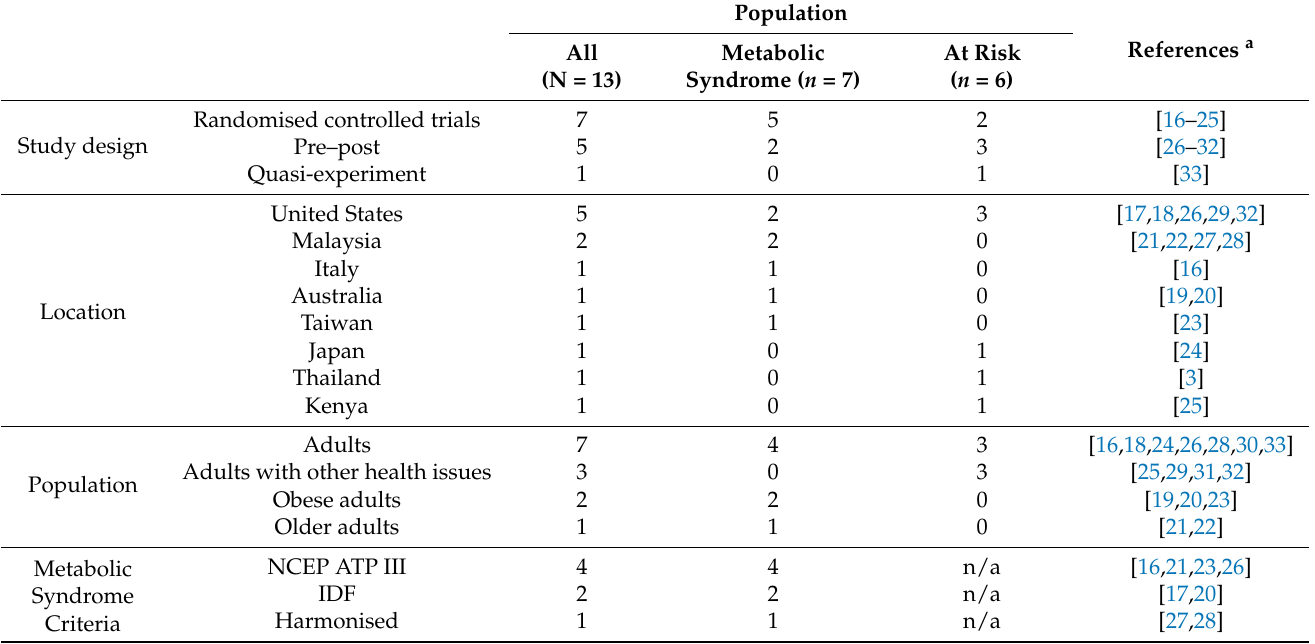
Table 1. General characteristics of the included studies (N =